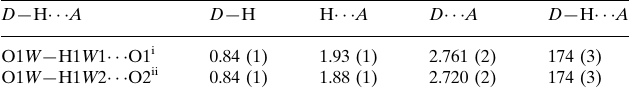
Hydrogen-bond geometry (A˚ , (cid:2)